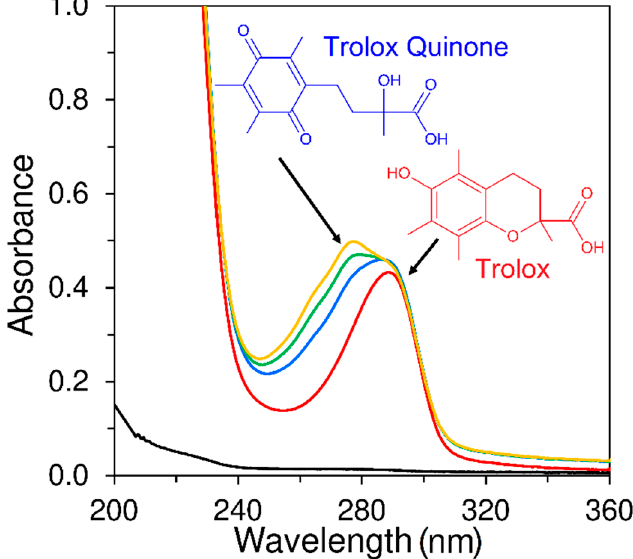
Figure 3. Ultraviolet spectra of 50 µg mL − 1 TYR (black) and 100 µmol L − 1 Trolox obtained in 0.1 mol L − 1 PB (pH 7.0) for 0 (red), 10 (blue), 20 (green), and 30 min (yellow line).